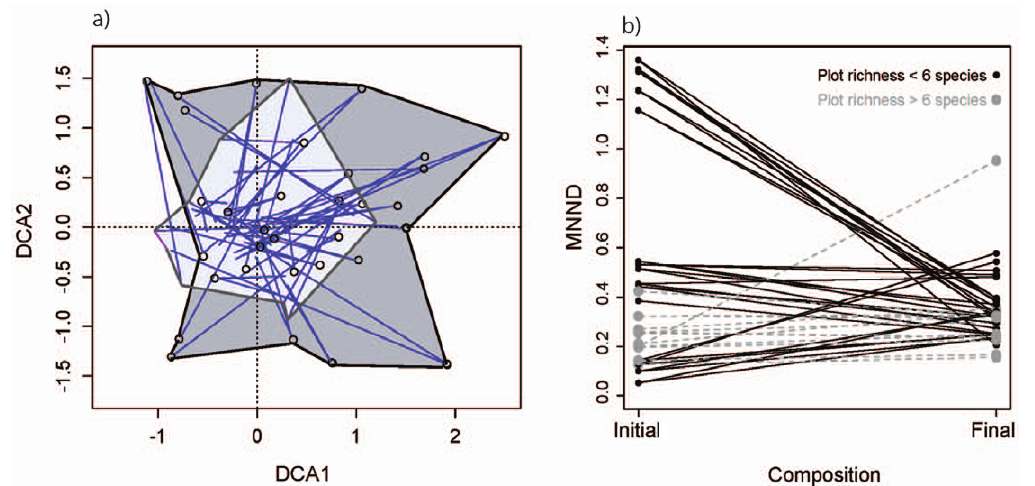
Figure 2. Detrended Correspondence Analysis of initial (dark grey) versus final (light grey) community compositional space (grey envelopes delineate outer envelope of starting composition of plots) (a). Circles are initial plots and lines end at final composition. Plot shows some compositional convergence, but substantial variation among plots remains. Convergence of mean nearest neighbor distances (MNND) (b), where diverse plots (i.e., with 8 or more more species—grey dashed lines) maintain MNND patterns despite species extinctions and species-poor plots (black solid lines) converge to high diversity MNND values.